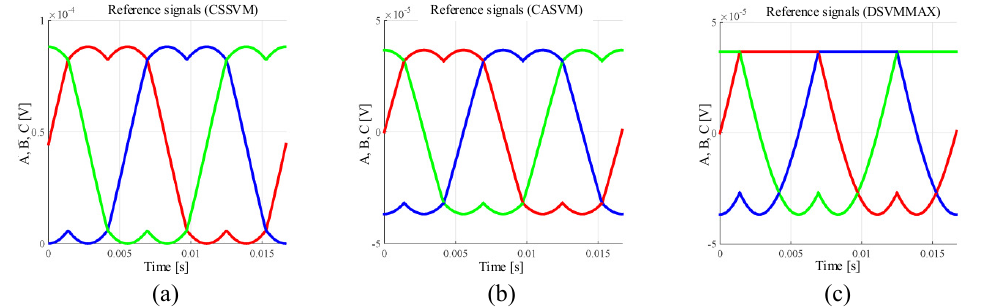
Figure 8. Reference signals for ( a ) CSSVM, ( b ) CASVM, and ( c ) DSVMMAX.